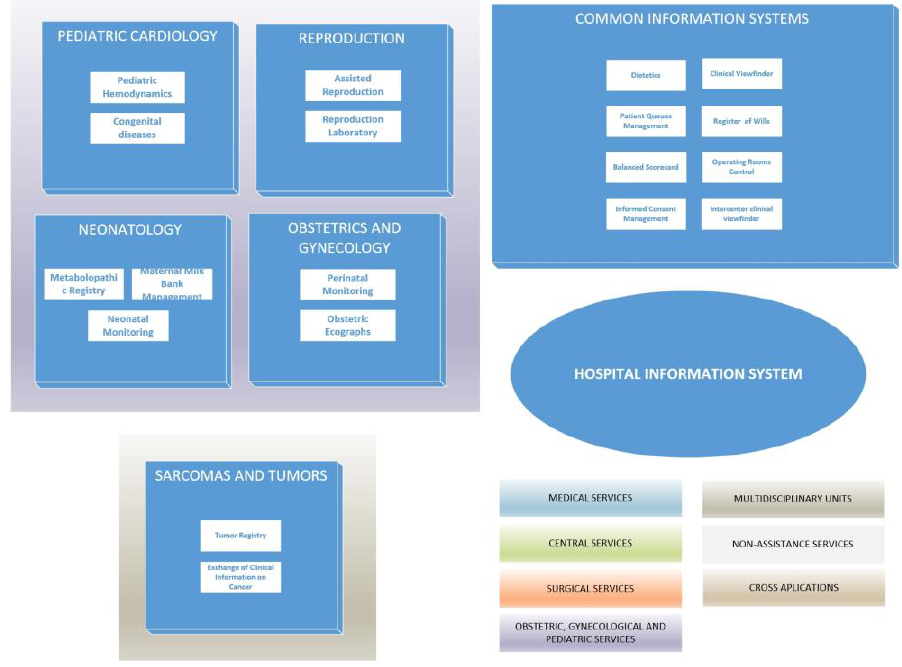
Figure 6. Relationship of information systems within clinical areas (IV).